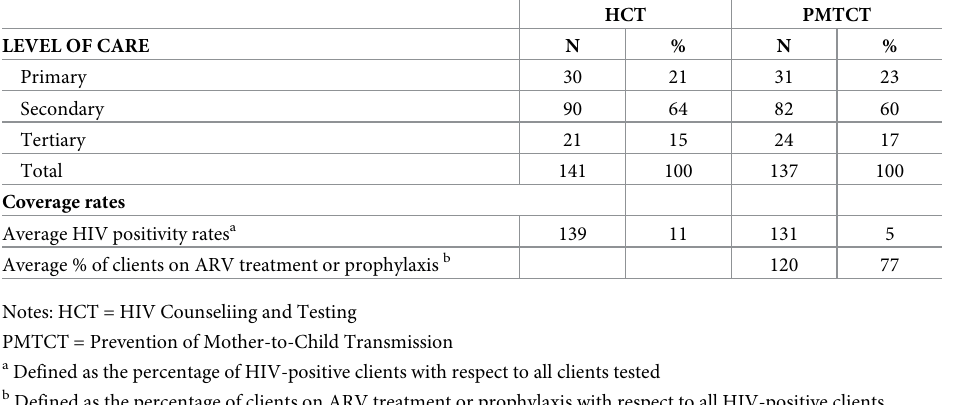
Table 1. HCT and PMTCT sample sites by facility type and cascade